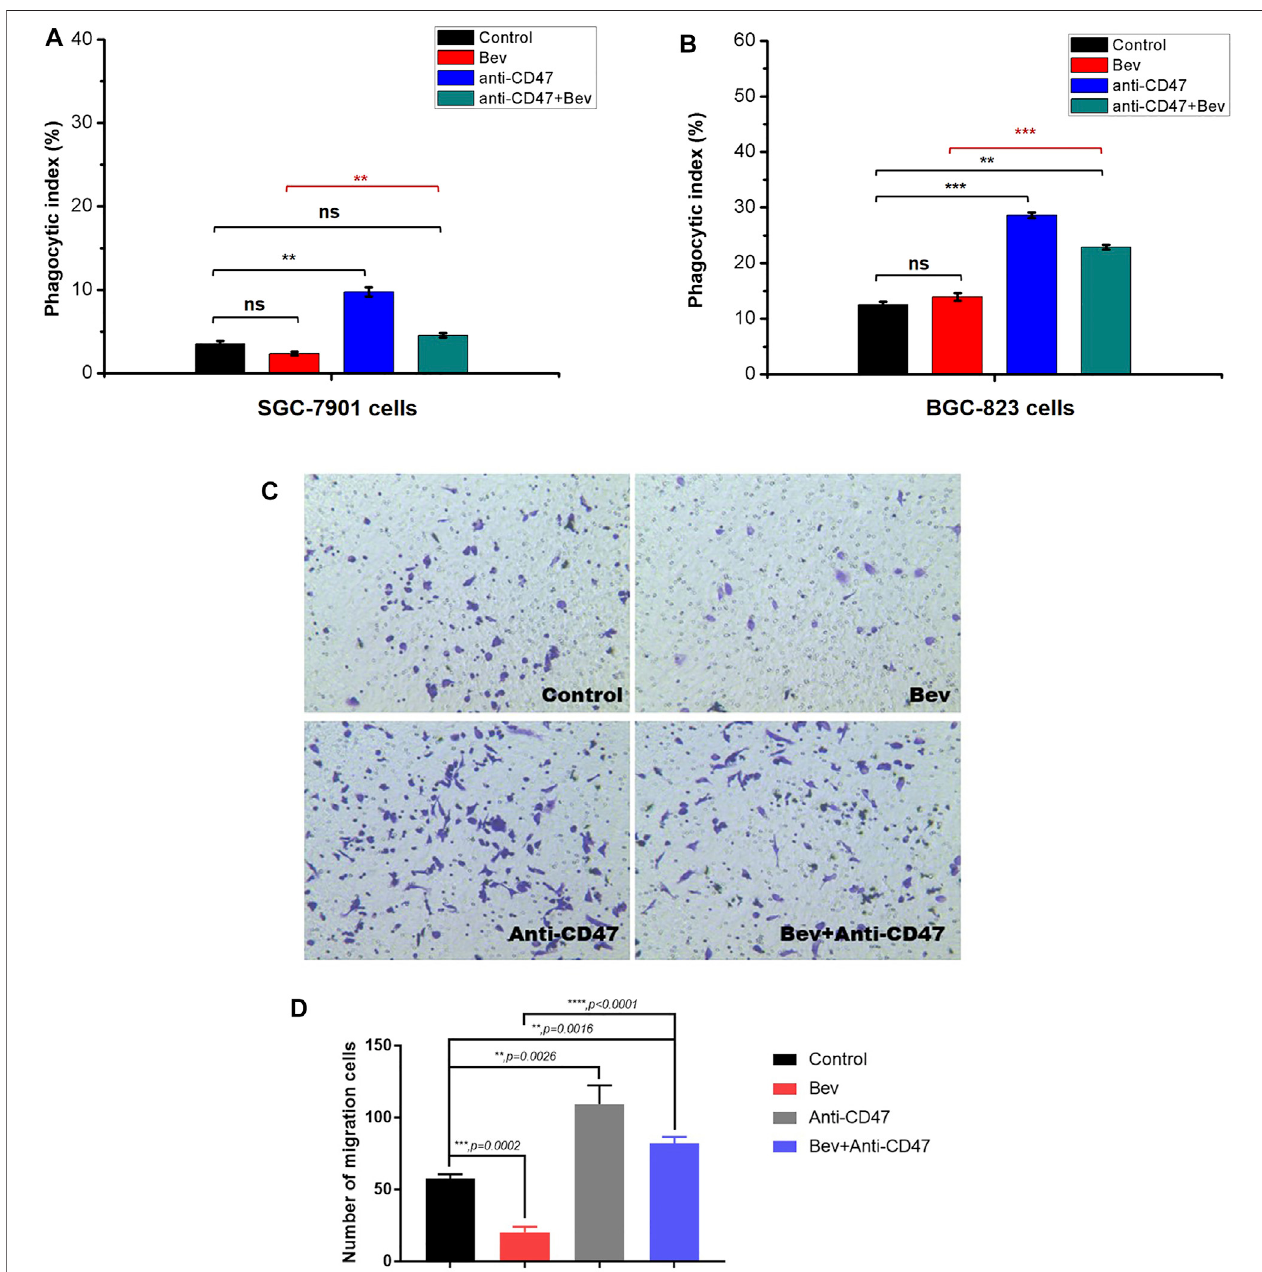
FIGURE 1 | Targeting CD47 reverses macrophage phagocytosis and migration to gastric cancer cells, reducing antiangiogenic therapy. (A) , (B) Phagocytic index indicating the phagocytosis of macrophages against gastric cells mediated with monotherapy or combination therapy (A SGC-7901 cells, B BGC-823 cells, n = 5). (C) , (D) BGC-823cellsandmacrophageswereculturedinTranswellchamberswithmonotherapyorcombinationtherapy.Migratedcellswerestainedwithcrystalvioletand counted. Magni fi cation was 200x. (E) H&E staining of monocyte in fi ltration in each group, scale, 50 μ m. (F) Fluorescence staining of CD68 to detect macrophage depletion, scale, 50 μ m. All the data are presented as the mean ± SD (* p < 0.05, ** p < 0.01, *** p < 0.001, and **** p <